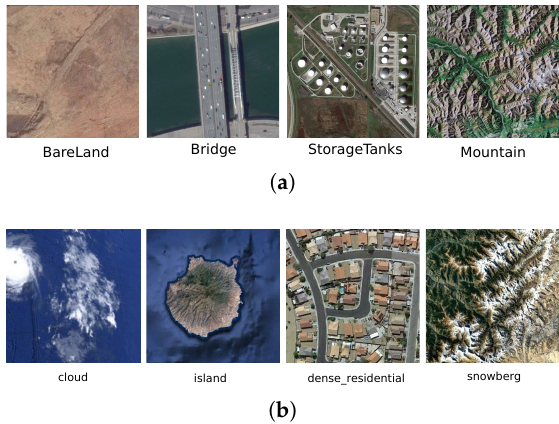
Figure 3. Some image examples of the AID ( a ) and NWPU-RESISC45 ( b ) archives used in